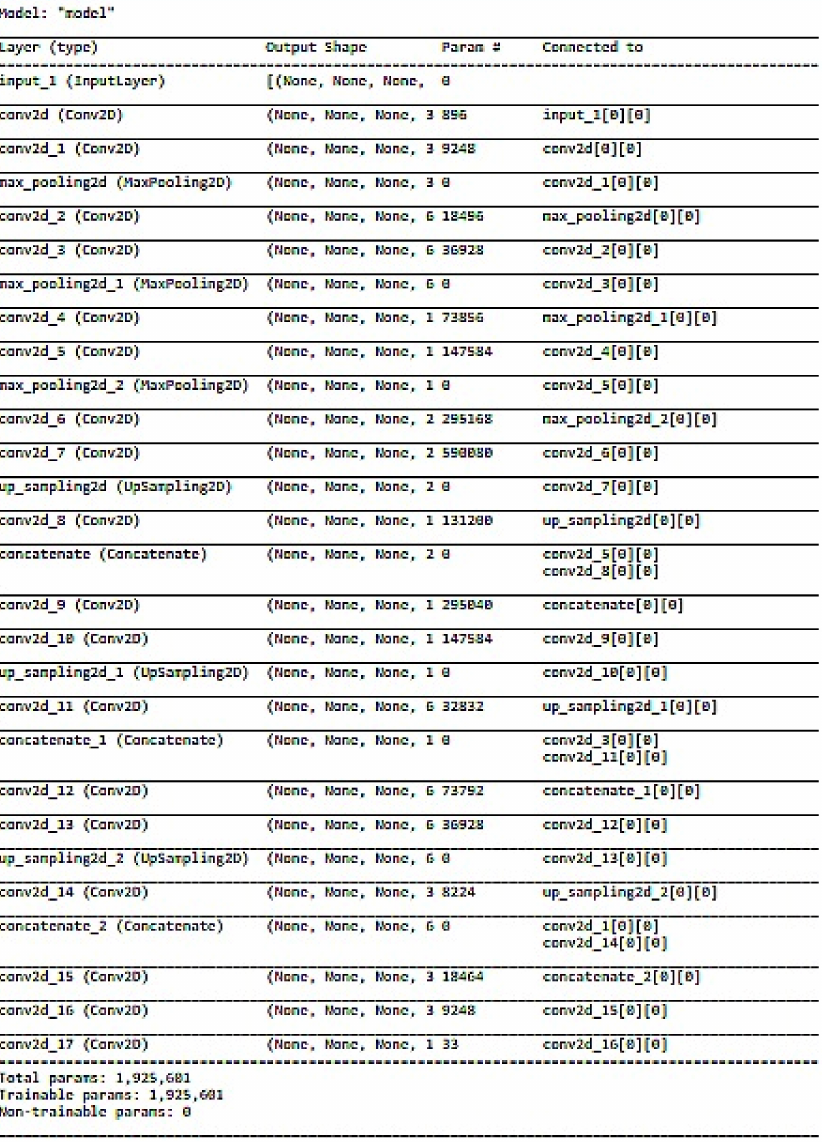
Figure 7. Summary of the